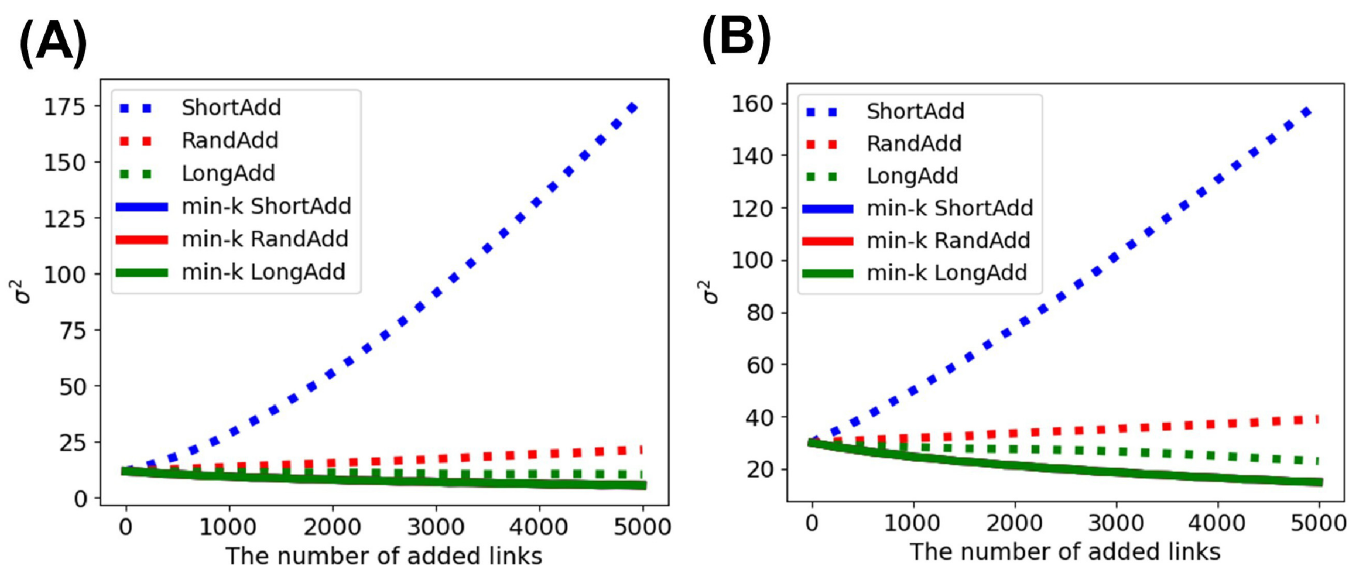
Fig 6. Variances of degree distributions after adding links to SF networks. The LongAdd method (green dotted line) decreases the variance, while the ShortAdd method (blue dotted line) increases the variance. The min- k RandAdd, min- k ShortAdd, and min- k LongAdd methods (three solid lines) are the same. The initial networks are SF networks with N = 1000 and (A) h k i = 2 or (B)